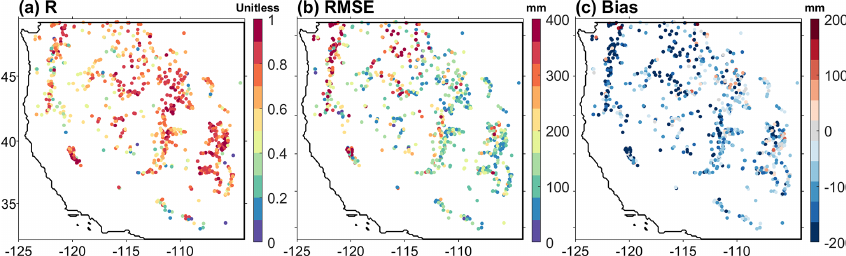
Figure 14. Spatial distribution of statistical metrics of ELM performance against the field snow water equivalent (SWE) data from SNOTEL: